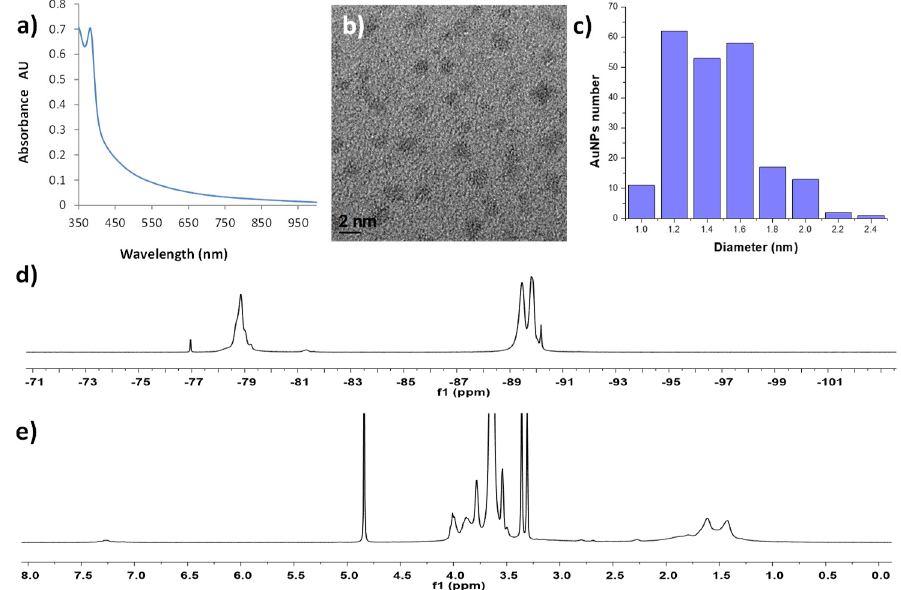
Figure 2. Characterization of NP-C6OF-PEG . Panel ( a ) UV-Vis spectrum in CHCl 3 of the nanoparticles; panels ( b , c ) representative TEM image and histogram of the size dispersion; panels ( d , e ) 19 F NMR (CD 3 OD, 470 MHz) and 1 H NMR (CD 3 OD, 500 MHz) spectra, respectively.